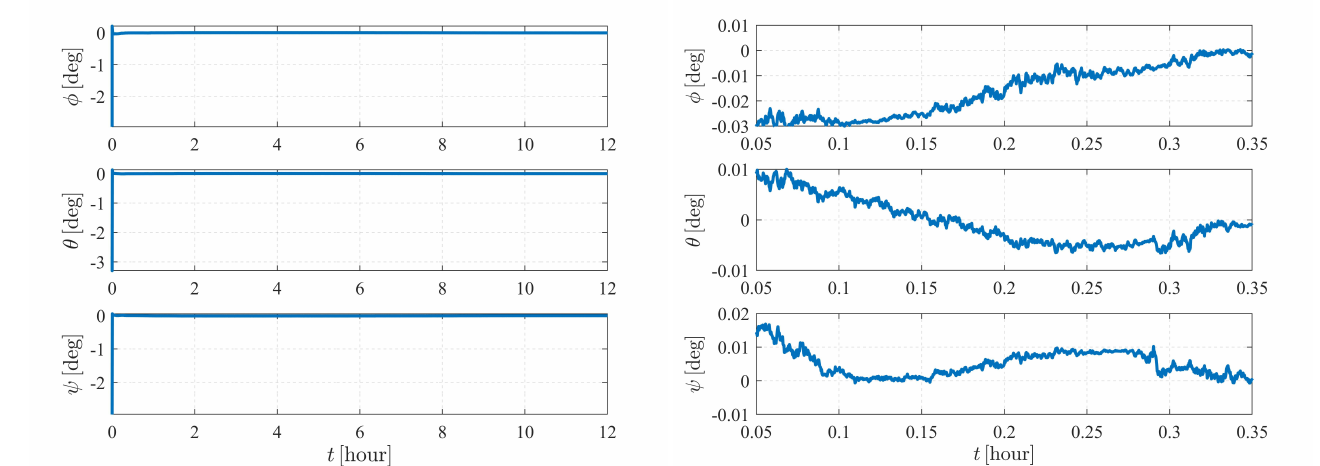
Figure 11. Attitude determination errors of case III (with J 2 , J 3 , and J 4 perturbations) and the corresponding larger plot.